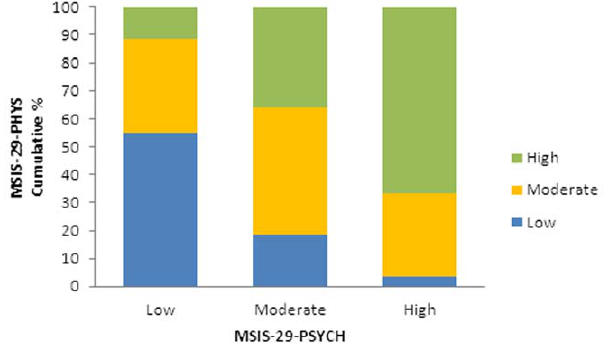
Figure 1. Proportions of respondents with low moderate and high MSIS-29-PHYS and MSIS-29-PSYCH scores. The scores were divided into tertiles: low moderate and high, and the proportions of respondents in each tertile for MSIS-29-PHYS and MSIS-29-PSYCH were compared.